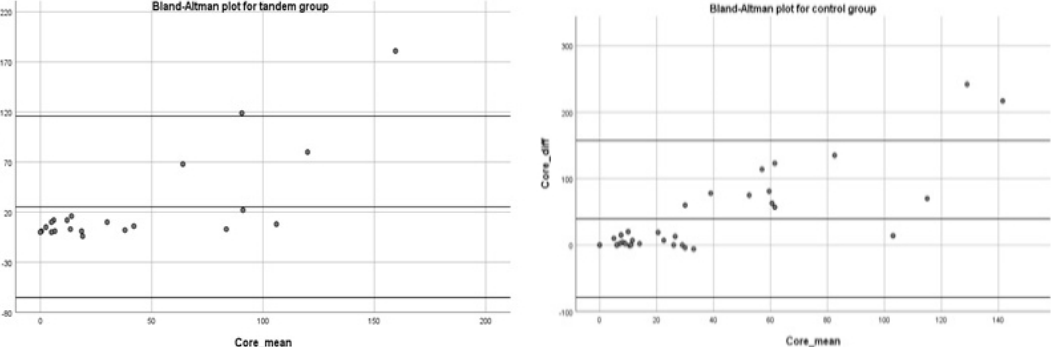
Figure 2. Bland–Altman plot for the tandem group (on the left ) and the MCA–LVO control group (on the right ).